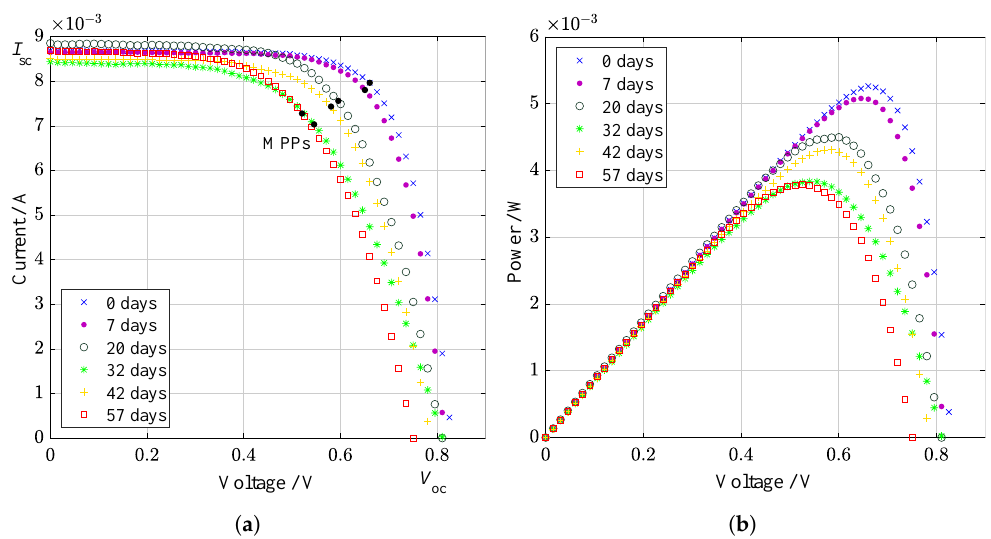
Figure 1. Light I–V curves from supercontinuum laser irradiation. In subfigure ( a ), I–V characteristics are indicated as maximum power points (MPPs). In subfigure ( b ), the power characteristics show a slight increase in performance may be observed during 42th day.